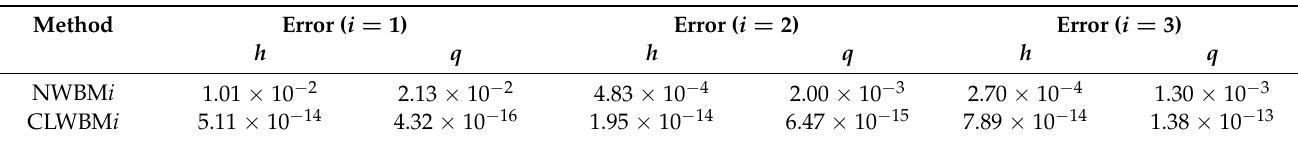
Table 12. Test 3.2. Differences in L 1 -norm for NWBM i and CLWBM i ( i = 1,2,3) with respect to the stationary solution using a 200-cell mesh at time t = 5 s.